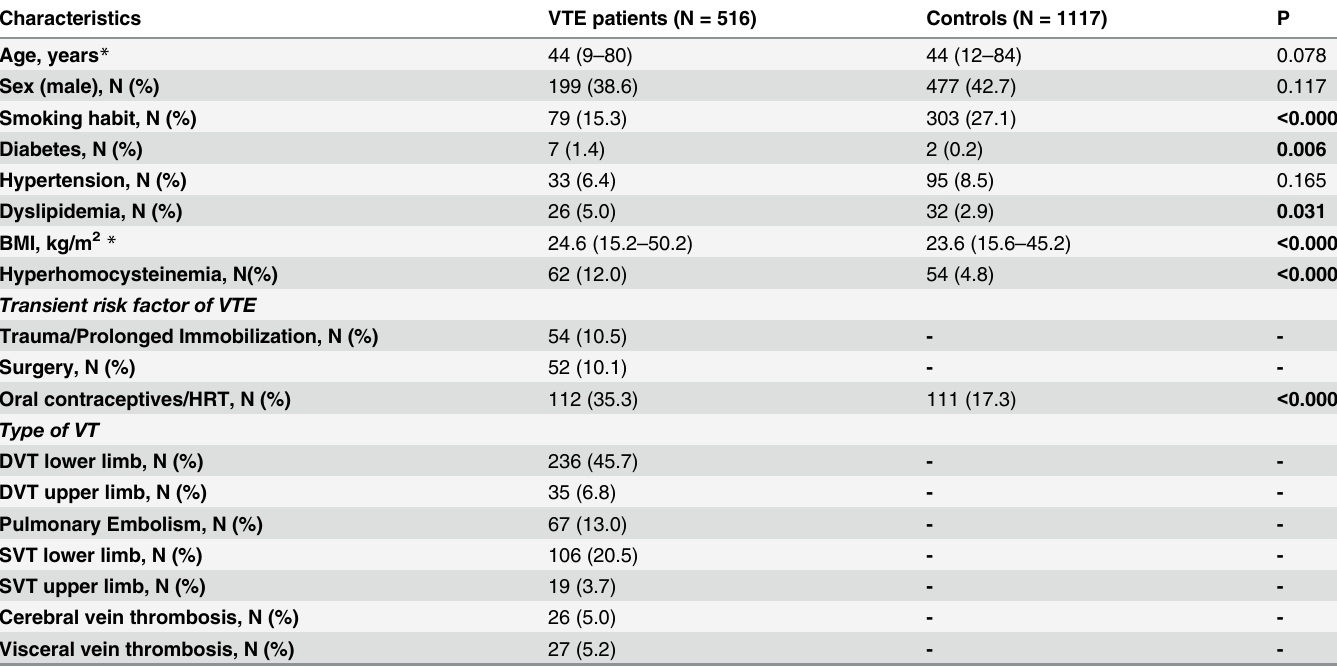
Table 1. Demographic and clinical characteristics of patients with venous thromboembolism (VTE) and control